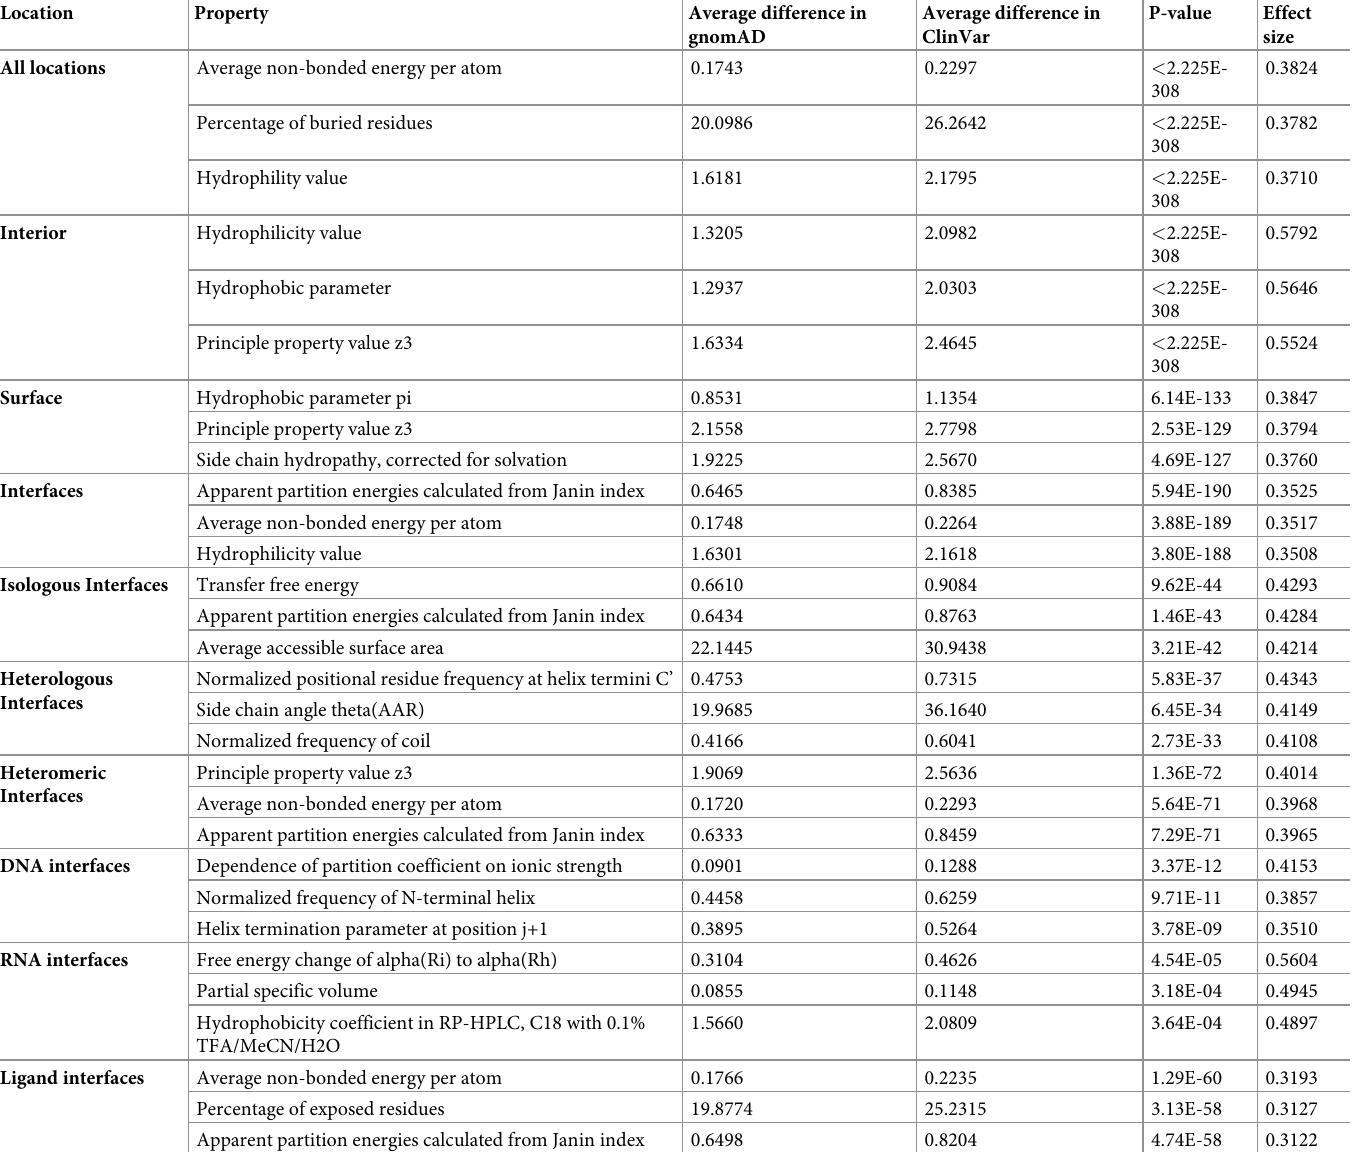
Table 1. Top three property changes by effect size at different protein